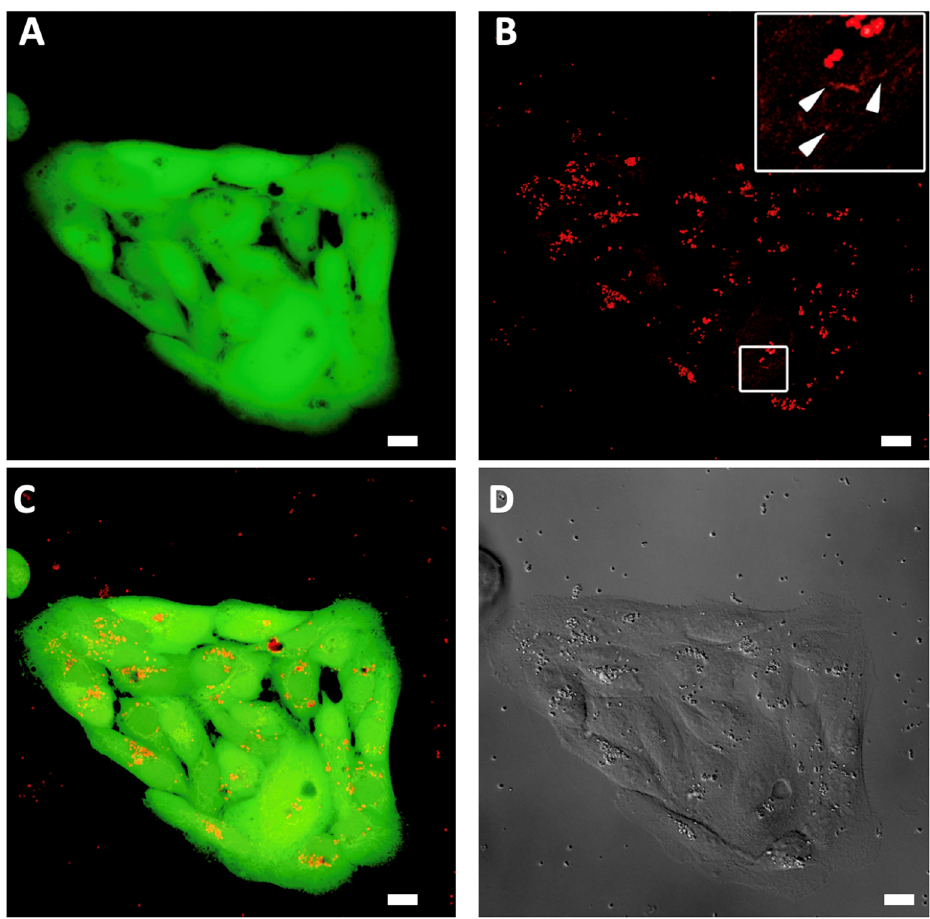
Figure 2. Confocal microscopy imaging of ARPE-19 cells fed with lipofuscin granules and incubated for 48 h after white light irradiation. Excitation: 532 nm. ( A ) living cells labeled by fluorescein diacetate (FDA); ( B ) lipofuscin granules autofluorescence in 570–620 nm detection channel (white arrows point to perinuclear areas with structure relevant to mitochondria morphology); ( C ) merged; ( D ) transmitted light channel. The measuring bar corresponds to 10 µm.